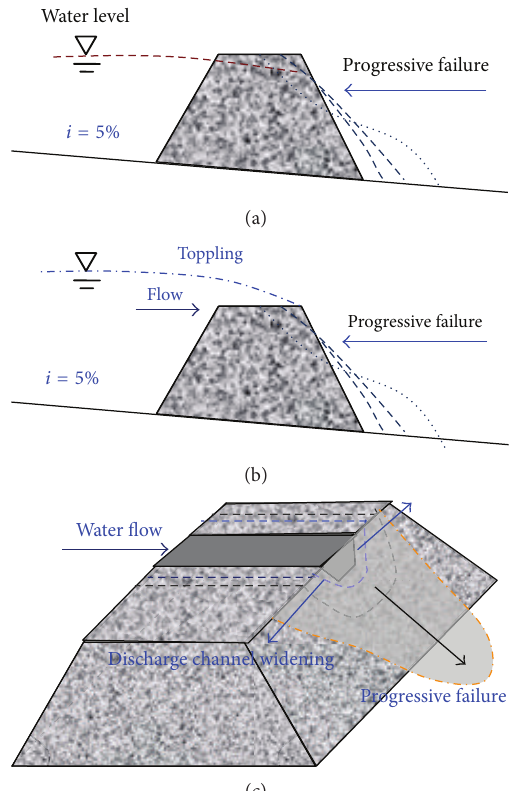
Figure 19: Three dam break models for landslide dams: (a) progressive penetration failure, (b) progressive failure and erosion by the toppling flow, and (c) erosion failure for the discharge channel.